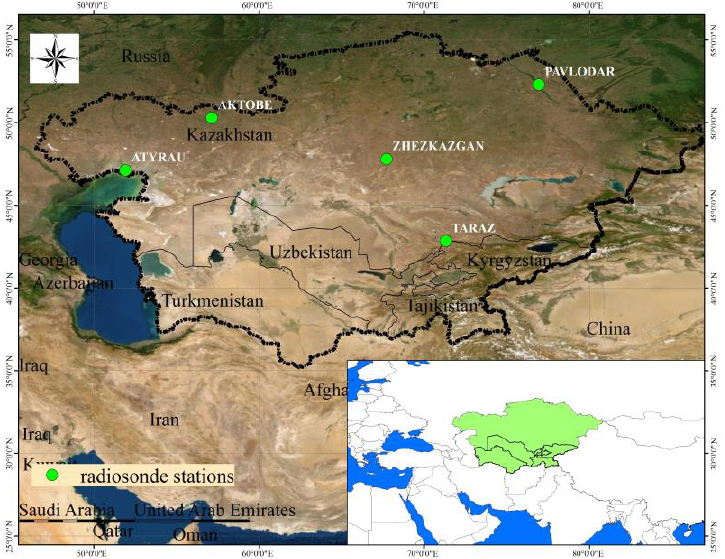
Figure 1. Topography andradiosonde stations in Central Asia.